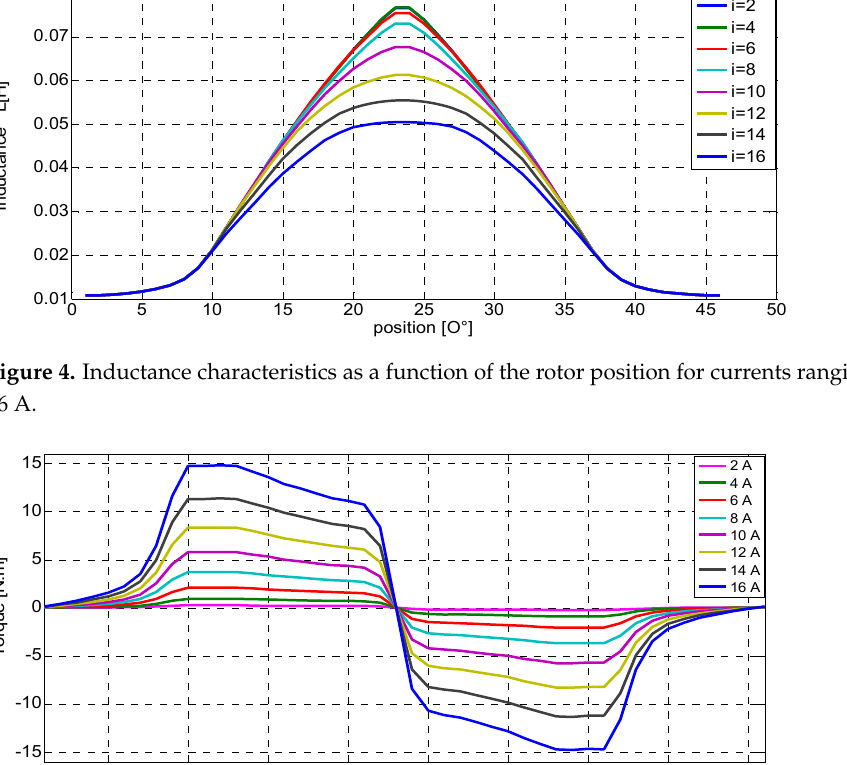
Figure 5. Static torque characteristics as a function of the rotor position for currents ranging from 2 to 16 A.